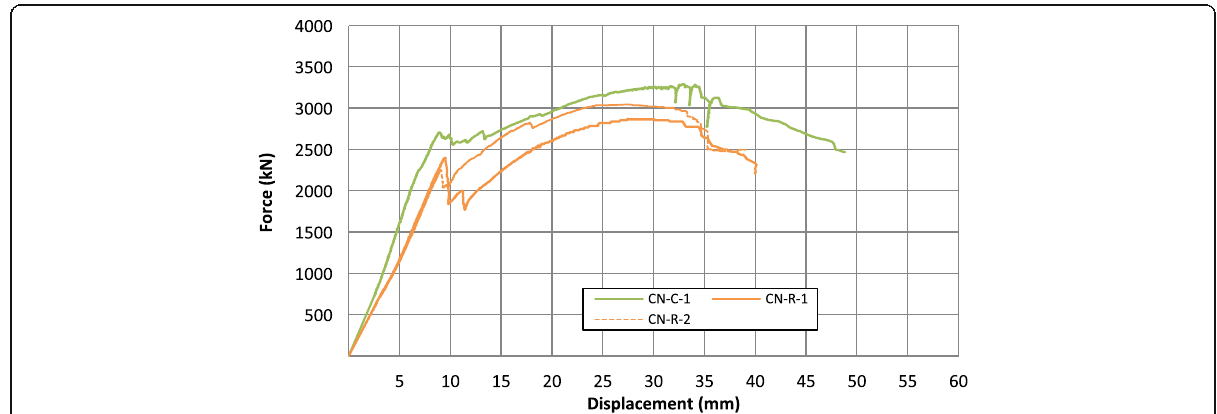
Fig. 14 Compression force versus axial displacement for CN series specimens with stainless clad vertical bars and stainless steel